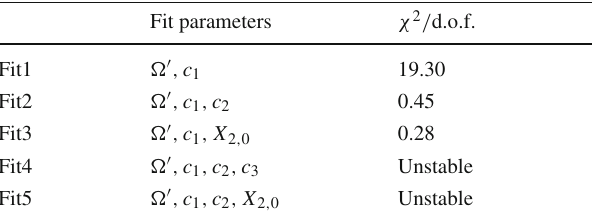
Table 2 Summary of χ 2 / d.o.f. for different types of fits of N τ versus